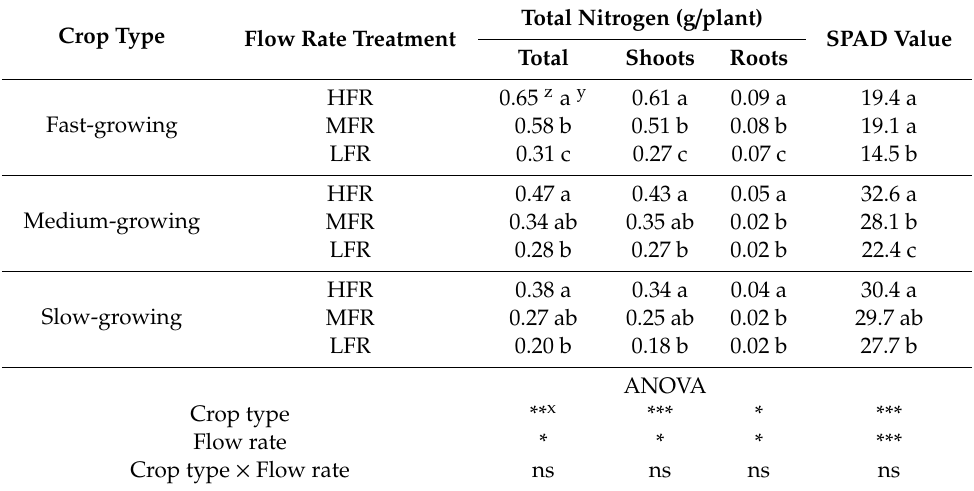
Table 7. Total nitrogen content (g / plant) and SPAD value of fast-growing, medium-growing, and slow-growing crops grown in aquaponics at high (HFR, 3.3 m / day), medium (MFR, 2.2 m / day), and low (LFR, 1.1 m / day) flow rate.